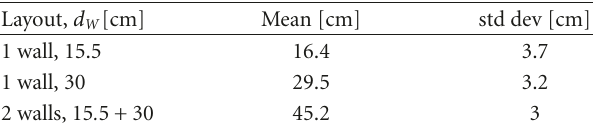
Figure 2: The configurations considered for DP excess delay characterization. (a) 1 wall with thickness d W = 15 . 5 cm or d W = 30 cm; (b) 2 walls with combined thickness 15 . 5 + 30cm. Table 1: Mean and standard deviation of ranging error for di ff erent wall thicknesses.